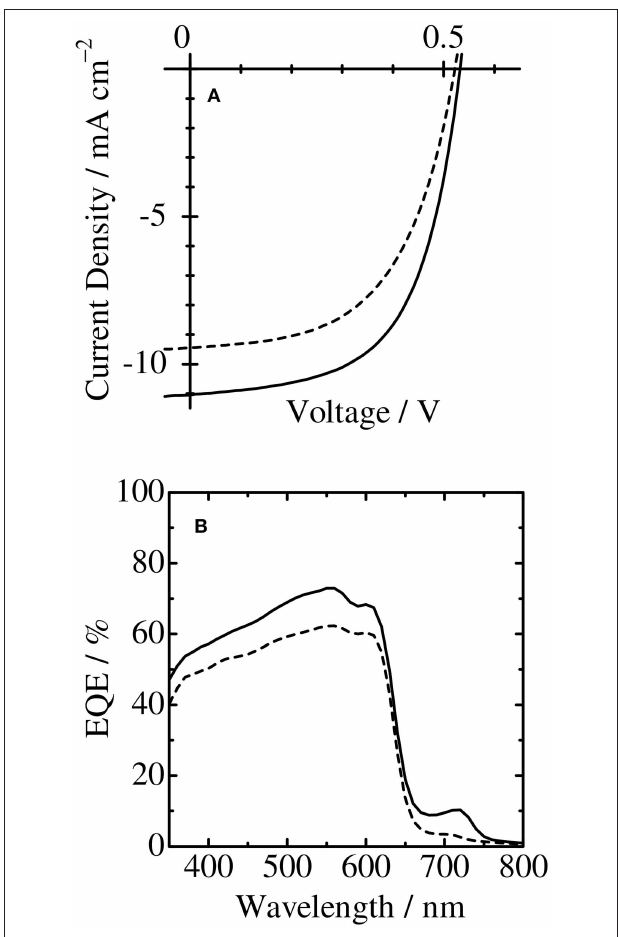
FIGURE 6 | (A) J – V characteristics and (B) external quantum efficiency (EQE) of P3HT/PCBM binary blend (broken line) and P3HT/PCBM/PCDPP4T ternary blend (solid line) solar cells under AM1.5G simulated solar